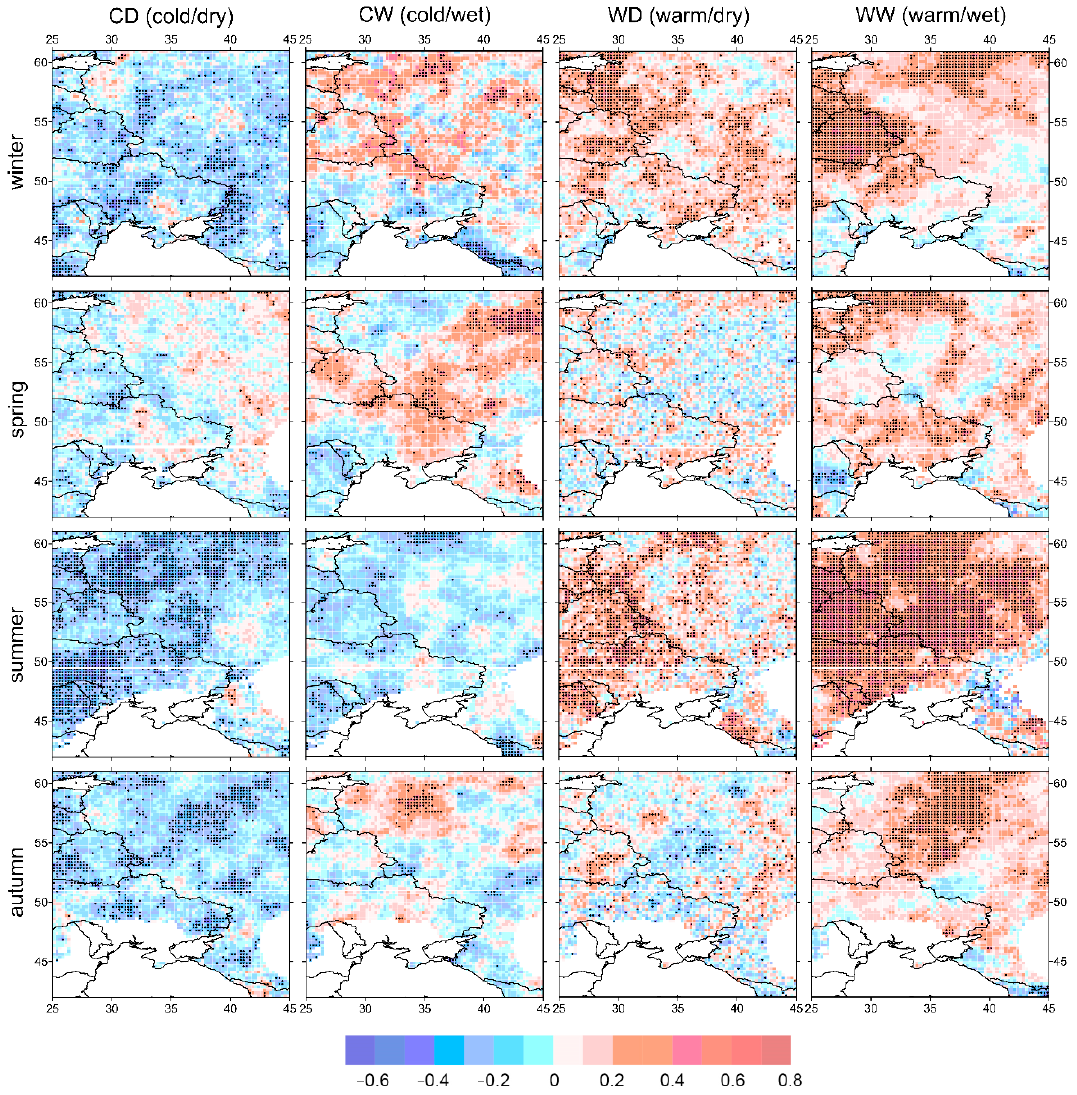
Figure 6. The spatial distribution of correlation coefficients for compound extreme indices and the EA. Statistically significant correlation coefficients ( p < 0.05) are shown as black dots.